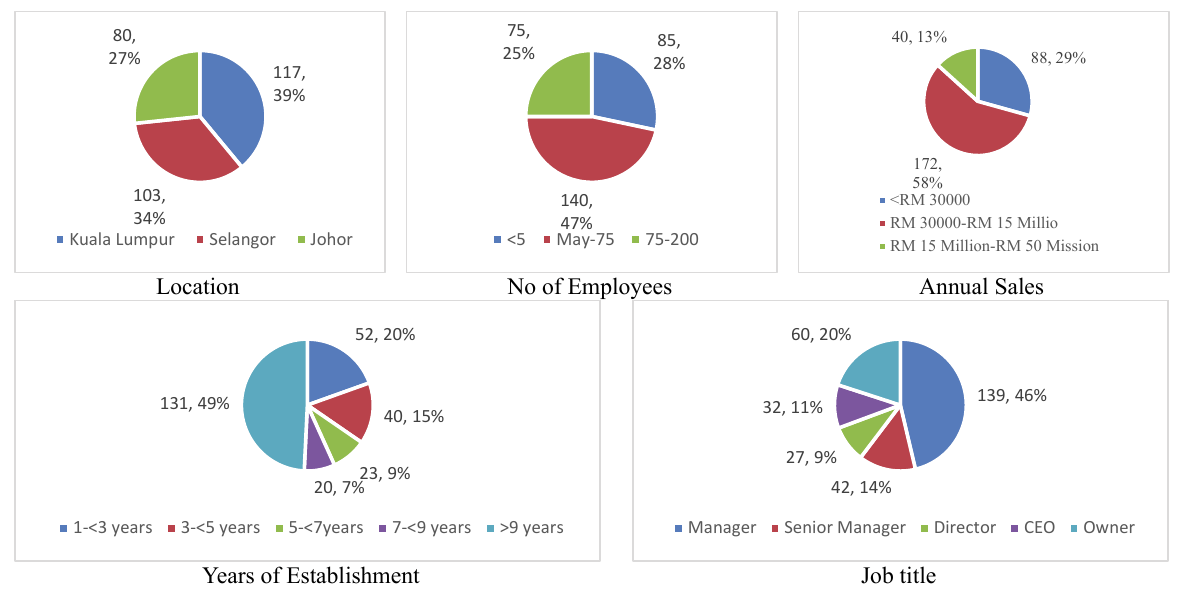
Fig. 2. Profile of the Respondents (n=300)